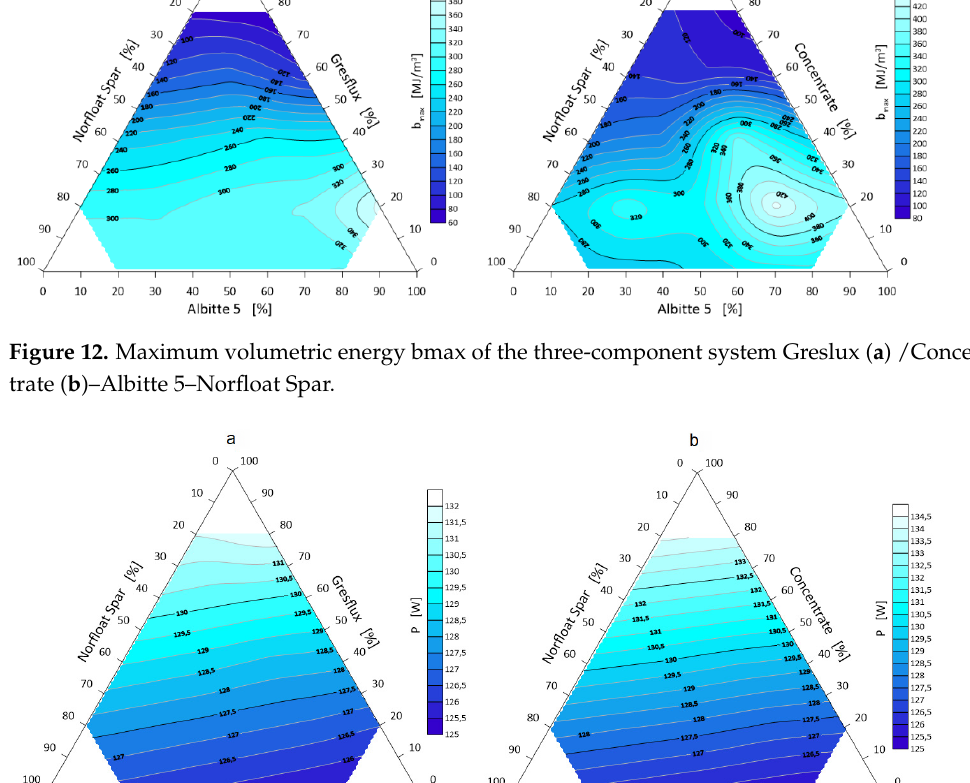
Figure 12. Maximum volumetric energy bmax of the three-component system Greslux ( a ) /Concen- trate ( b ) –Albitte 5–Norfloat Spar.